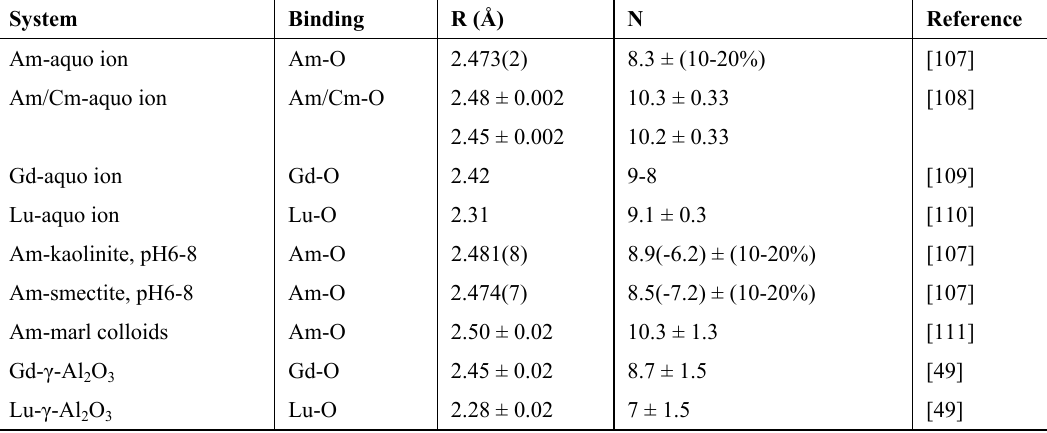
Table 5. Results of EXAFS data obtained for lanthanides/actinides adsorbed to γ -Al and clay